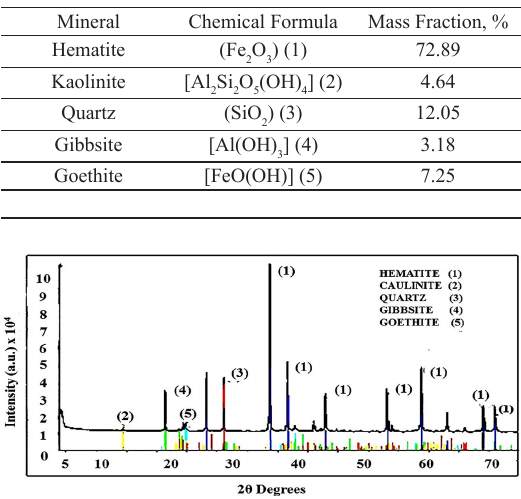
Figure 2. X-ray diffraction spectrum of the iron ore sample.